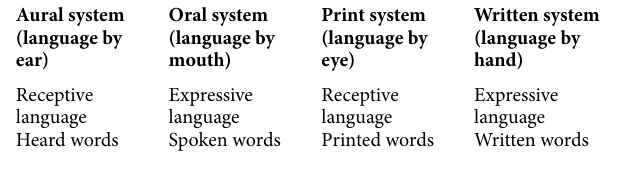
Table i. The four language systems that children have to acquire Aural system (language by